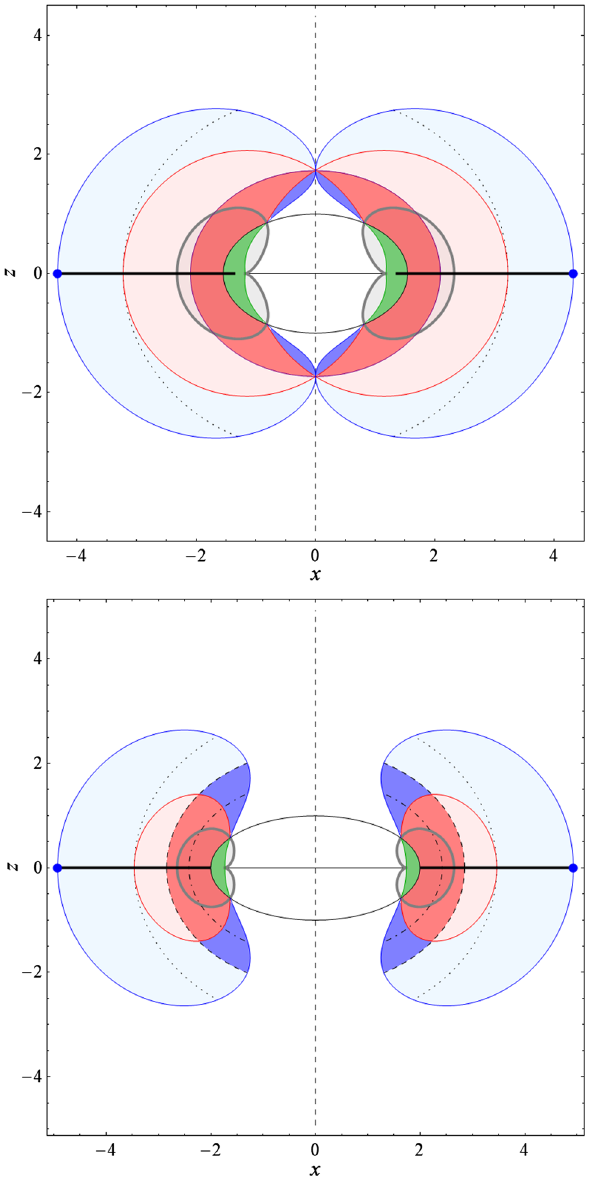
Fig. 18 Structure of the SPOs in the KNS spacetime with a = a pol ( max ) (above) and with a = 1 . 7 (below) corresponding to the Class V 27, where it becomes local minimum q sph , min = 27 for